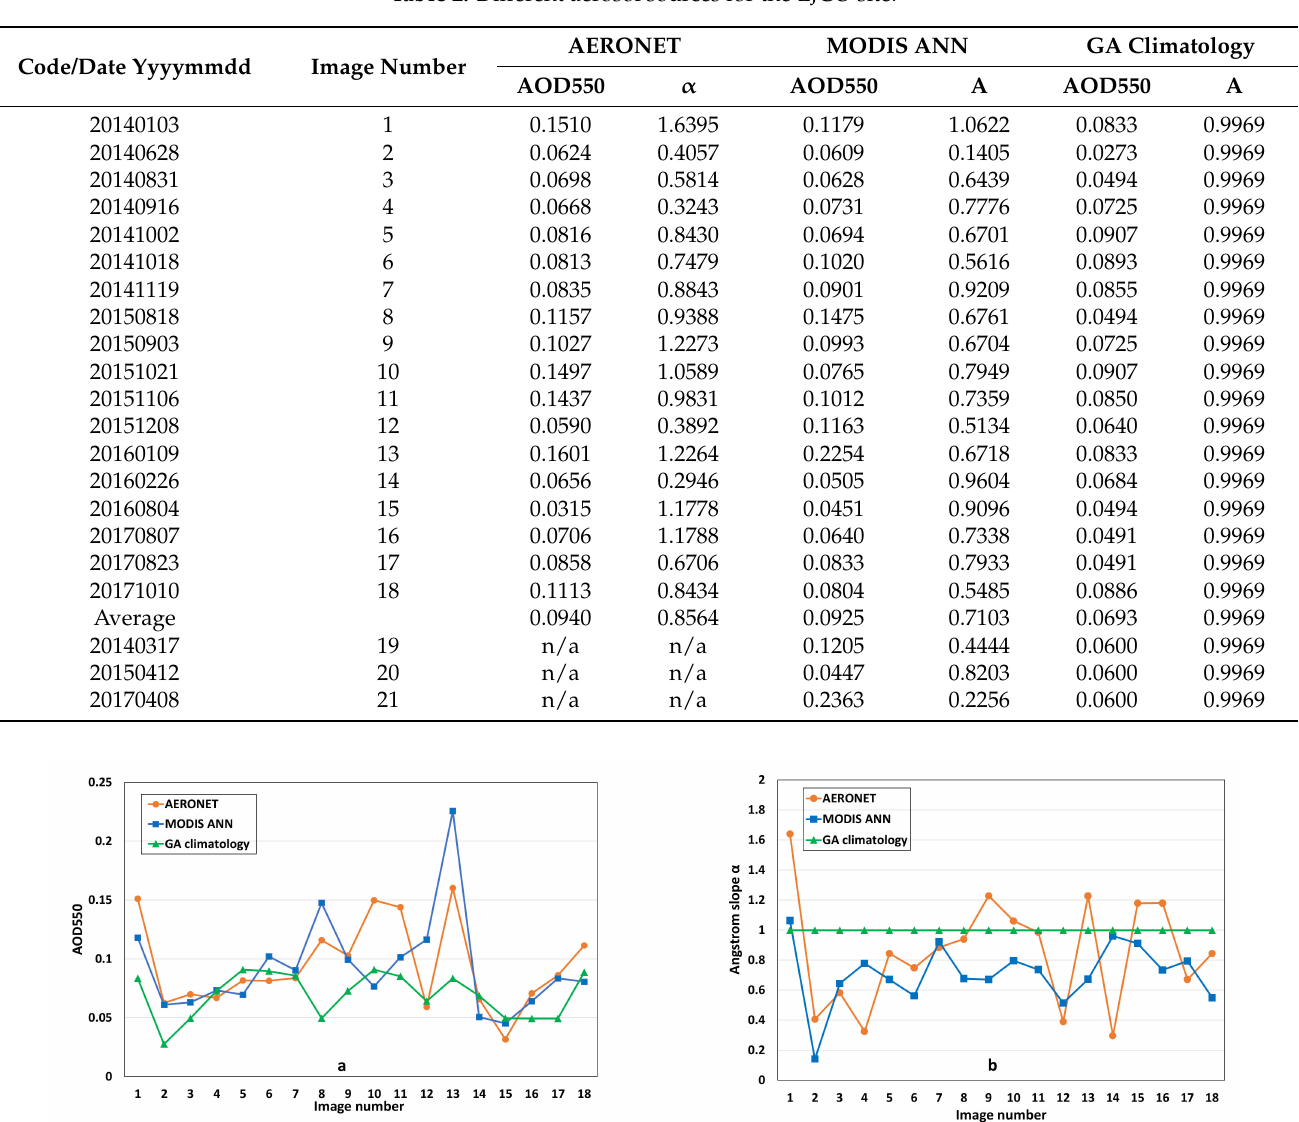
Table 2. Different aerosol sources for the LJCO site.